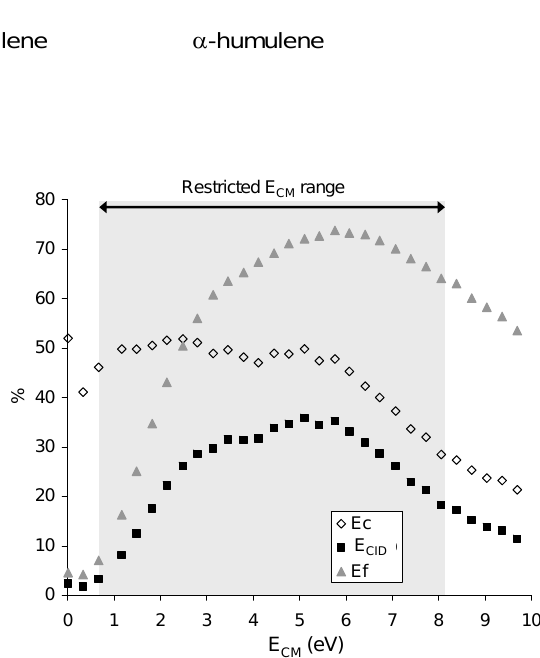
Fig. 3. Collection ( E c ), fragmentation ( E f ) and CID ( E CID ) ef- ficiencies (in %) as a function of collision energy ( E CM ) for the fragmentation of protonated α -cedrene. The restricted E CM range considered in this study is